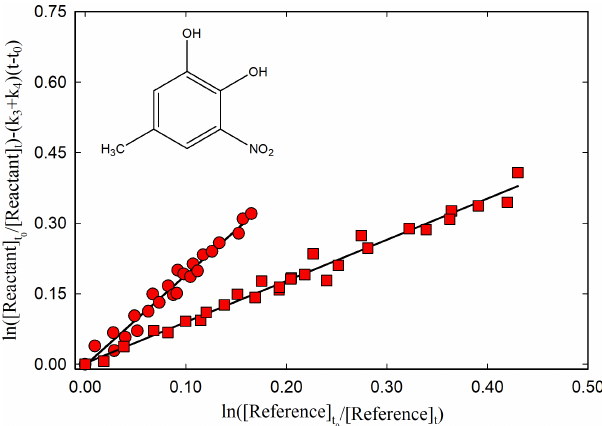
Figure 3. Kinetic plot according to Eq. (1) for the reaction of 5-methyl-3-nitrocatechol with OH radicals relative to dimethyl ether (red circle) and cyclohexane (red square) using photolysis of CH 3 ONO / NO mixture at 365nm as OH radical source, with ( k 3 + k 4 ) = (4.27 ± 0.98) × 10 − 4 s − 1 .